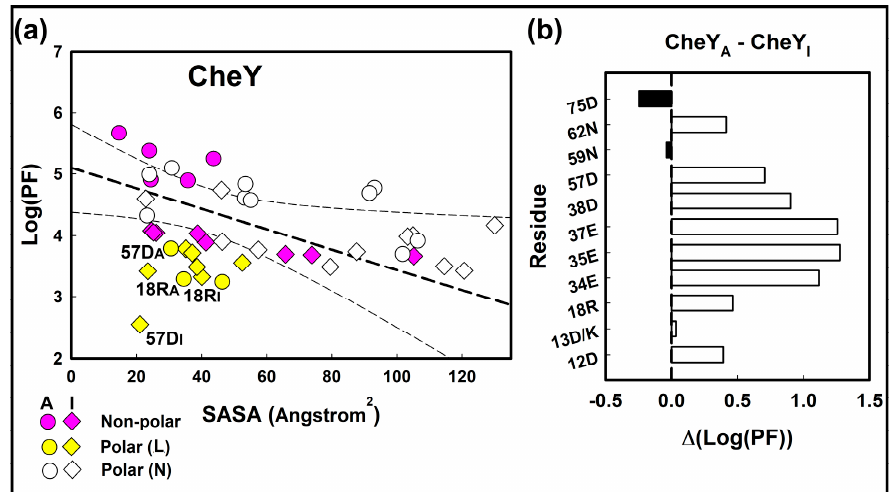
Figure 2. PF differences between residue types and activated states. ( a ). The solvent accessibility of non-polar residues (magenta symbols) varies linearly with SASA. The least-square best fit linear regression (thick dashed line) and 95% confidence limits (thin dashed lines) are shown. Most polar residues (white symbols (N)) follow the best-fit relation, but a significant fraction (yellow symbols (L)) have anomalously high solvent accessibility (low Log (PF)) A = CheY A , I = CheY I . ( b ). The activation-dependent change in polar residue Log (PF) values. There is a marked positive Log (PF) ( ∆ ( CheY A − CheY I )) increase for the 34E, 35E, 37E, 38D residue quadruplet ringing 57D, modest increases for 12D, 18R, 57D, 62N, and no significant change for 13D/K, 59N. The ∆ ( CheY A − CheY I ) Log (PF) for 75D outside the 57D solvation network has a negative